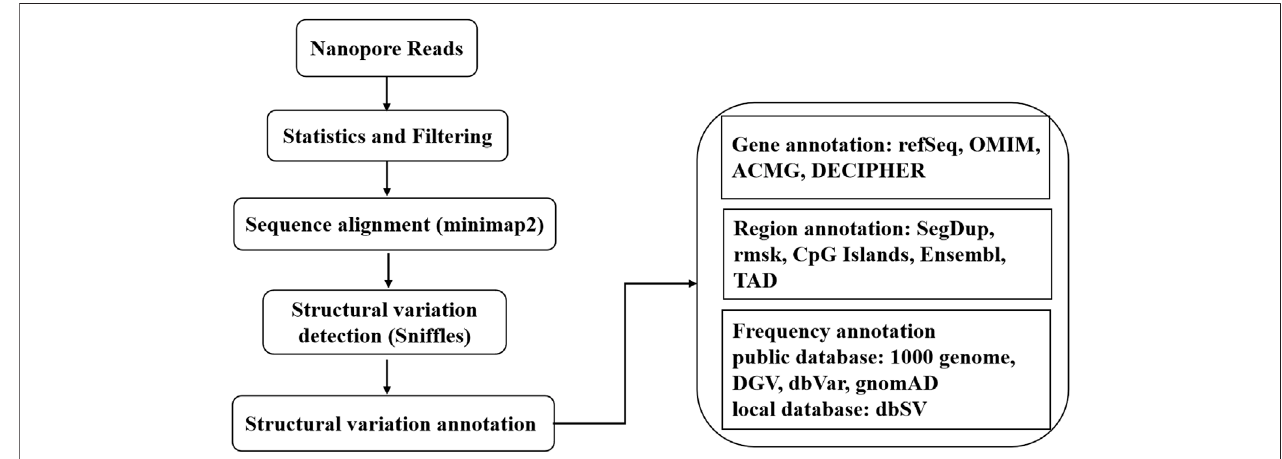
FIGURE 1 | The work fl ow of bioinformatics analysis. The nanopore sequencer generated 3,385,816 reads containing 55.25 Gb. After fi ltering, 50.50 Gb with 2,964,325 reads were retained. The total number aligned to the human genome was 47.16 Gb, with 2,845,728 reads. A total of 603 SVs were annotated in ANNOVAR according to the above databases. More details are summarized in Table 1 , Supplementary Table S2, S3 .